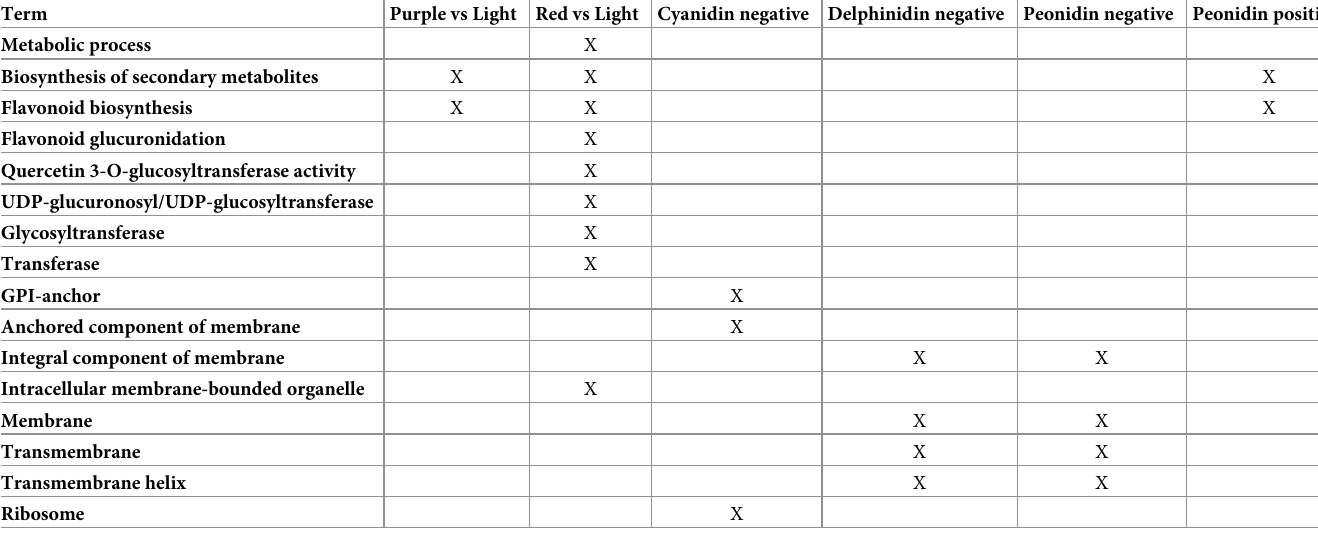
Table 2. Gene set enrichment analyses. Summary of significantly enriched terms in gene sets from analyses of DEG (Purple vs Light and Red vs Light) and ExM (cyani- din, delphinidin and peonidin). Terms enriched in a specific set (FDR < 0.1) are indicated with “X”. ExM sets were divided between genes showing positive or negative correlations. Only sets with significantly enriched functions are presented. Complete results are presented in S2